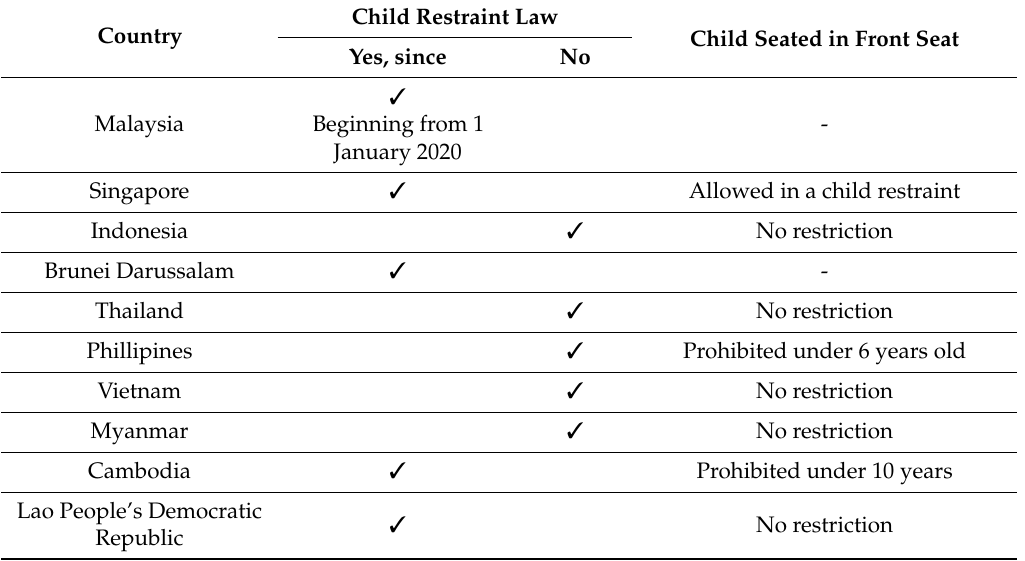
Child Seated in Front Seat